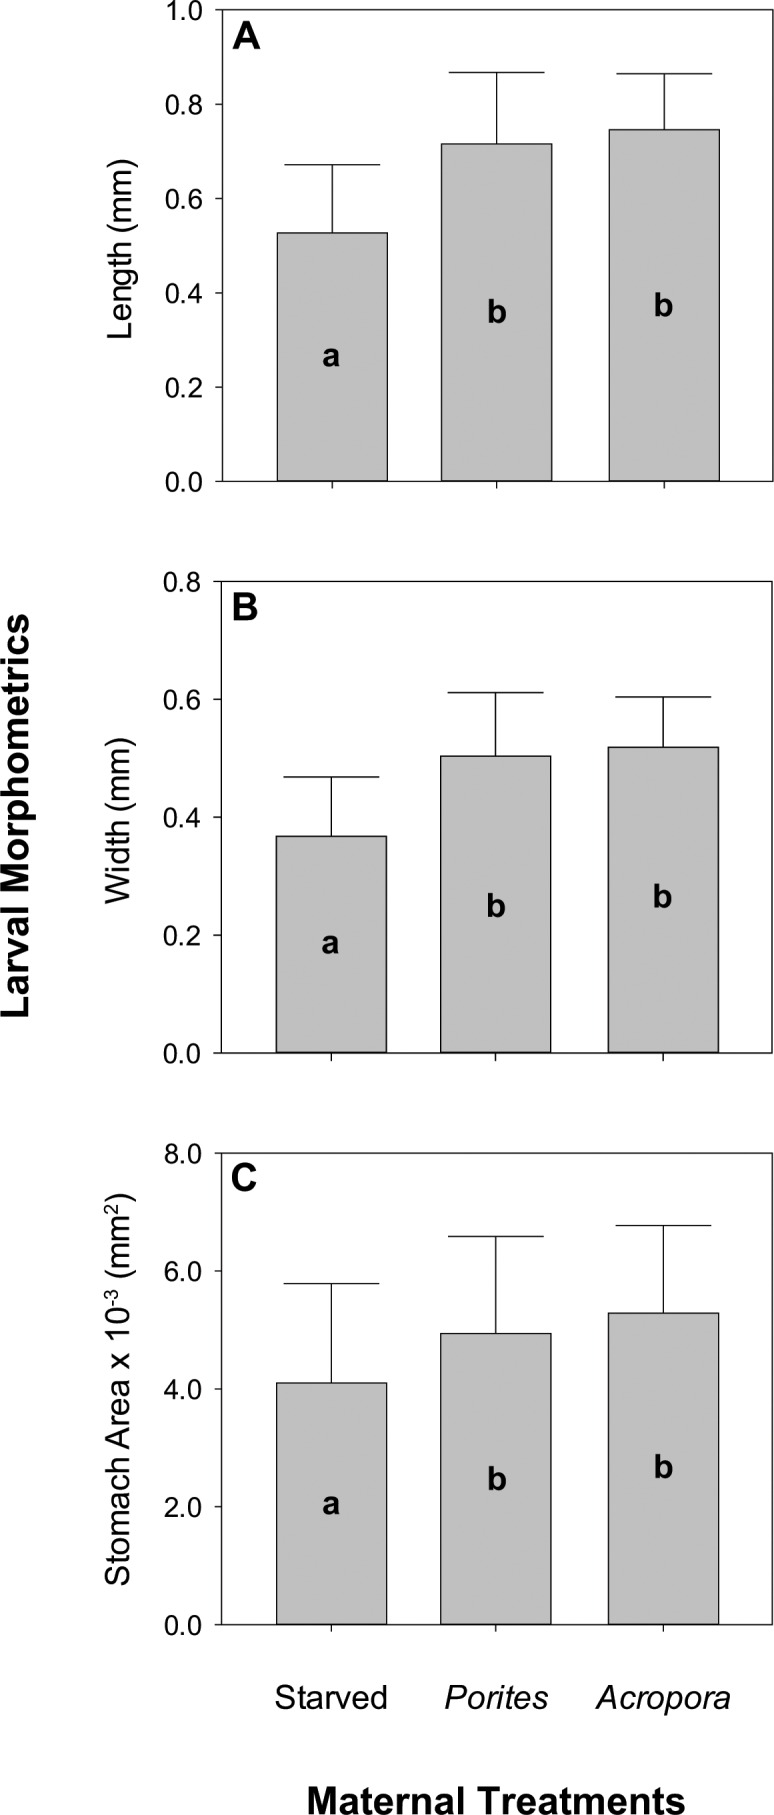
Morphometrics of larvae from females under different nutritional treatments.Image analysis measurements of (A) length, (B) width, and (C) stomach area (n = 10). Error bars are + 1 SD and different letters are significantly different based on Tukey’s post hoc test.